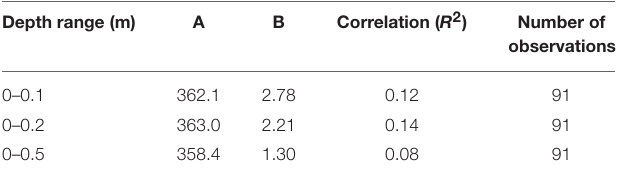
TABLE 1 | Fit coefficients and statistics for parameterization P1 (Equation 1).